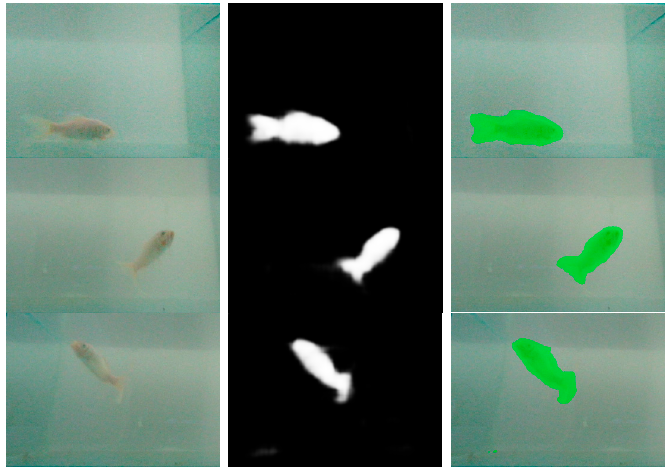
Figure 14. Results on the model M2.